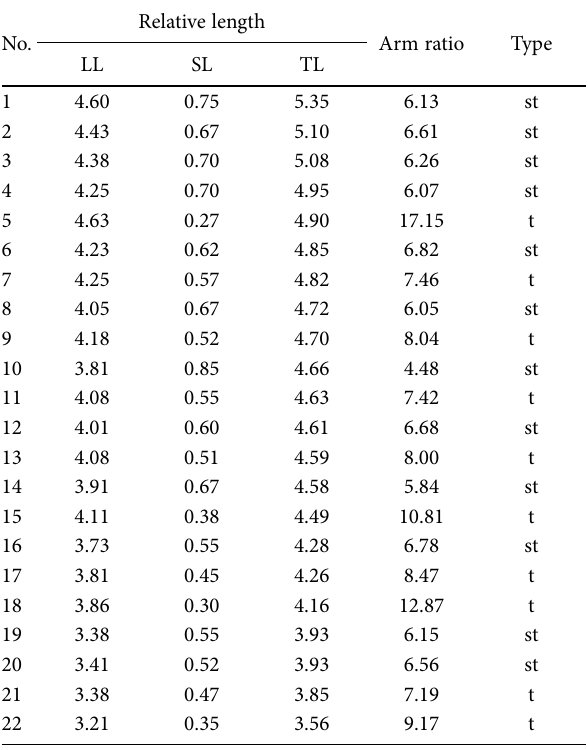
Table 4. Measurements of somatic chromosomes of L . radiata . Relative No.